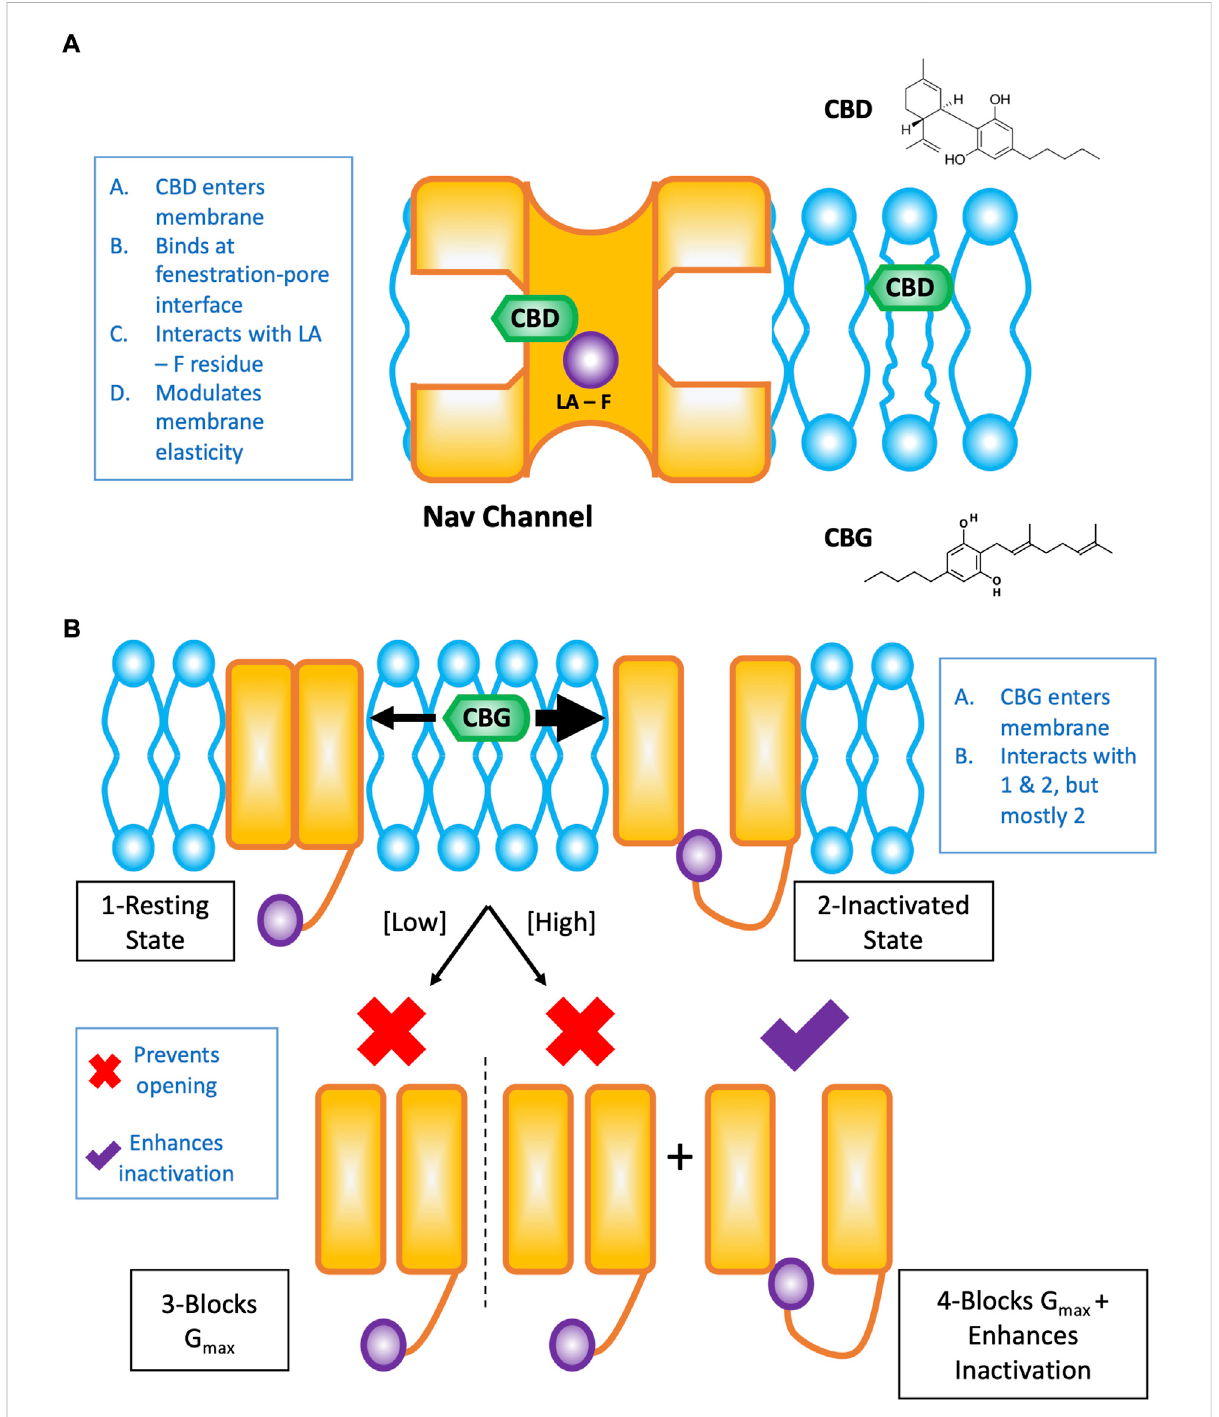
FIGURE 1 CartoonsummaryofCBDandCBGeffectsonNavchannels.This fi gureisaredrawnversionofourpreviouslypublishedpapers(Ghovanlooand Ruben, 2021; Ghovanloo et al., 2022a). (A) Shows the pathway of CBD from the lipid phase through the mammalian Nav fenestration and into the pore, where it interacts to some extent by the local anesthetic (LA) site with the pore phenylalanine (F) residue. (B) Cartoon representation of the concentration-dependentmodalityofCBGeffectsonNavchannels.CBG,likeCBDisastate-dependentNavinhibitorwithanincreasedaf fi nity for the inactivated state. Overall, however, CBG causes a reduction in total conductance/channel opening more potently than inactivation is stabilized in the presence of